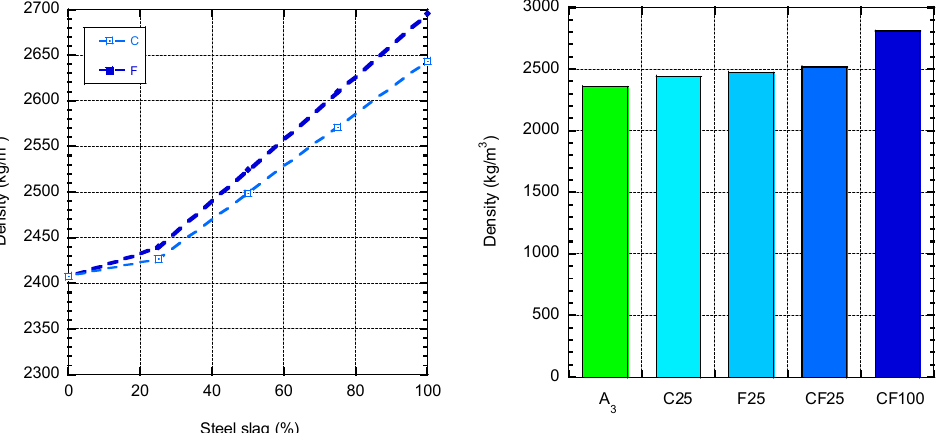
Figure 5. Slump of concrete containing different percentages of micro-silica ( left ) and slump of concrete optimal each of the previous parts ( right ).